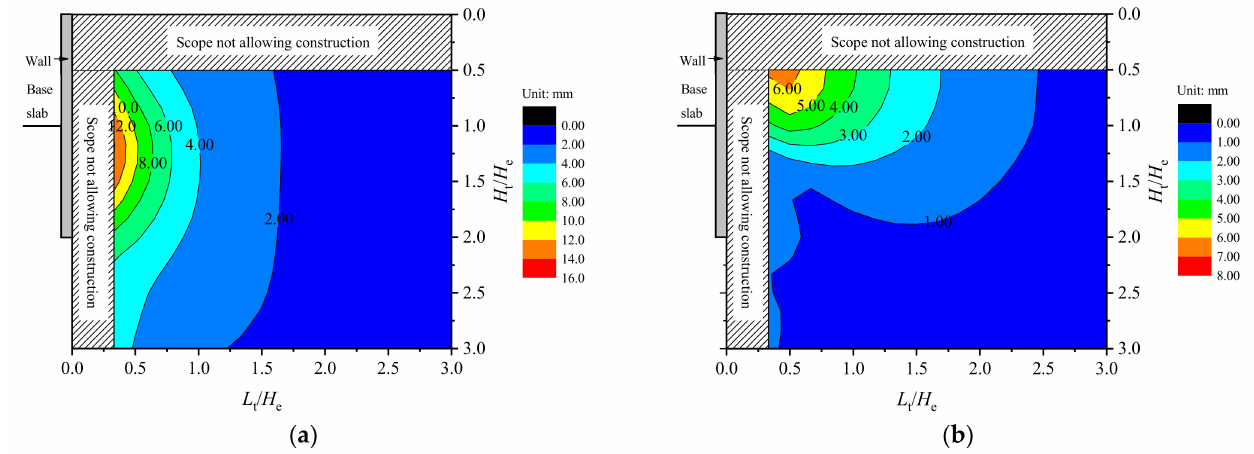
Figure 15. Isolines of tunnel displacement after ground improvement: ( a ) horizontal displacement isoline; ( b ) vertical displacement isoline.